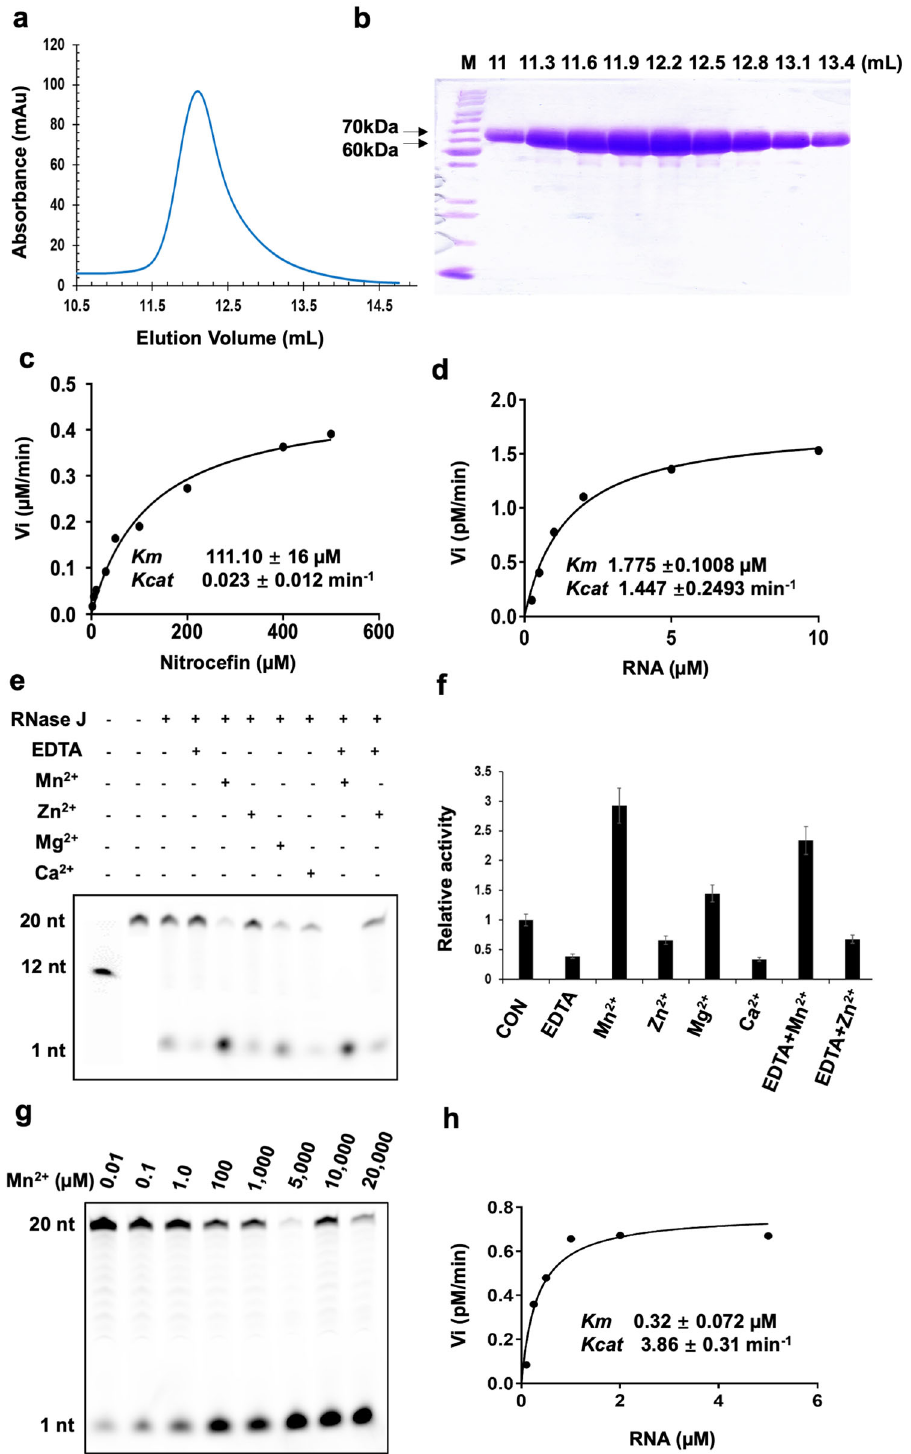
Fig.1|BiochemicalcharacterizationofMtb-RNaseJ.a Gel fi ltrationpro fi leoffull- length Mtb-RNase J on a Superdex200 16/300 column. b SDS-PAGE result of the corresponding fractions in ( a ). c The β -lactamase activity of Mtb-RNase J with the substratenitroce fi n. d TheribonucleaseactivityofMtb-RNaseJwith5 ′ -FAMlabeled 20-nt poly(U) RNA as the substrate. e , f . Different divalent ions affected the ribo- nuclease activity of Mtb-RNase J. The concentrations of divalent metal ions and EDTA were 5mM and 10mM, respectively. 5 ′ -FAM labeled 20-nt poly(U) RNA